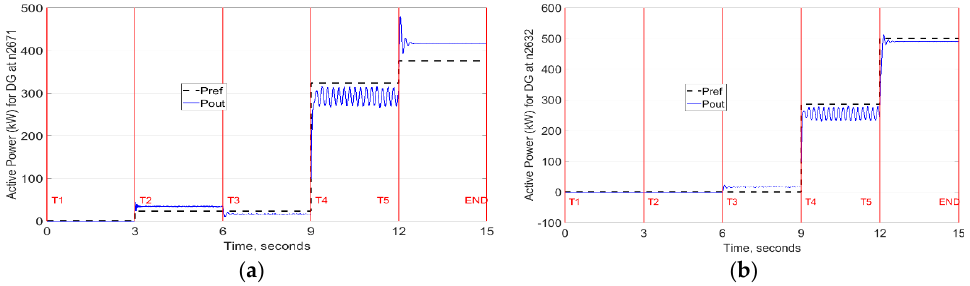
Figure 15. Droop reference active power and output active power for DGs at nodes ( a ) 2671 and ( b ) 2632 as obtained from PSCAD simulation.